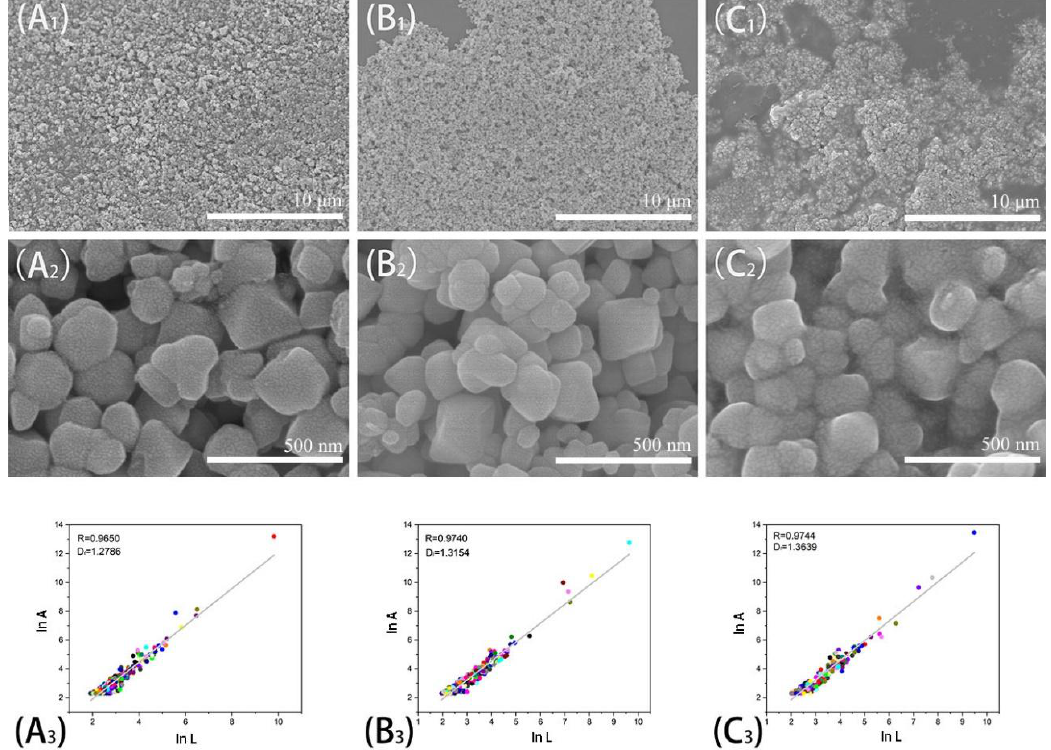
Figure 5. SEM and fractal dimensions of APAM-Fe 3 O 4 ( A 1 , A 2 , A 3 ), TAPAM-Fe 3 O 4 ( B 1 , B 2 , B 3 ) and TAPAM-PDA-Fe 3 O 4 ( C 1 , C 2 , C 3 ). (The dots in A 3 , B 3 and C 3 were corresponding to the linear correlation of the logarithm of projected area A and the characteristic length